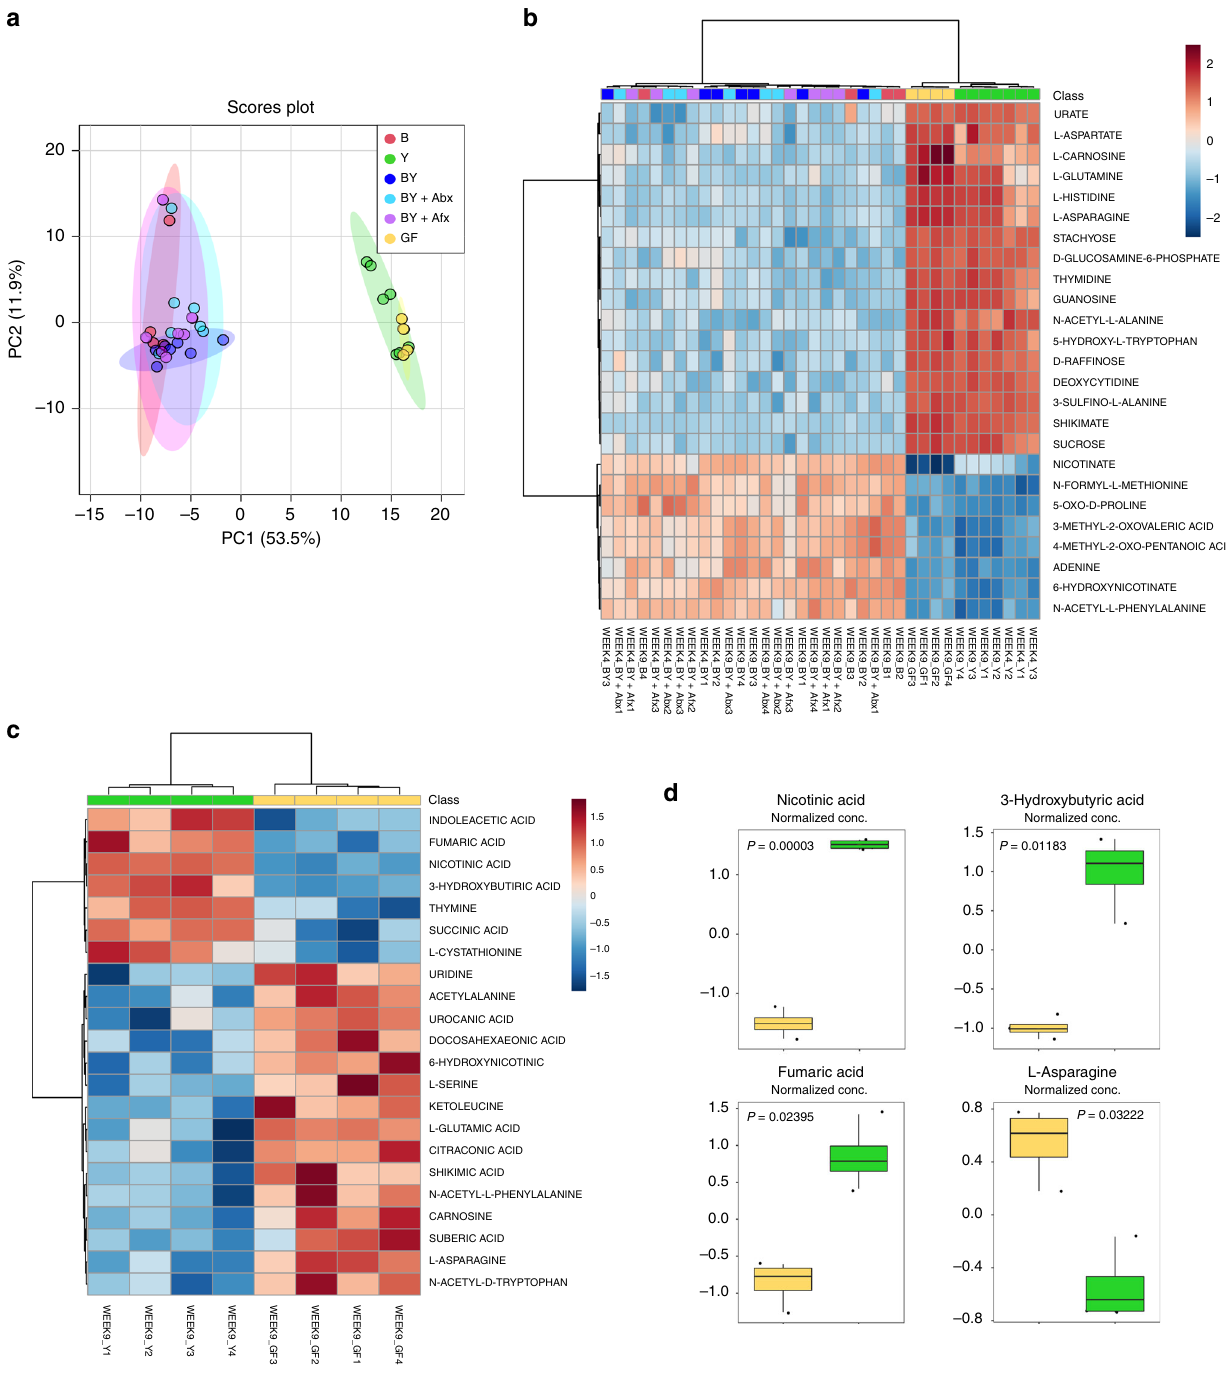
Fig. 4 Bacteria colonization is the main driver of changes in the fecal metabolome. a Principal component analysis score plot of 150 metabolites detected in fecal samples of gnotobiotic mice at 4 and 9 weeks of age. b Heat map of top 25 differentially expressed metabolites detected in 4- and 9-week fecal samples. c Heat map of 22 metabolites differentially expressed between GF and Y groups at 9 weeks. d Strongest metabolic differences detected between GF and Y groups at 9 weeks. a – d Color denotes colonization treatment (GF = yellow, B = red, Y = green, BY = royal blue, BY + Abx = cyan blue, BY + Afx = purple); N week4 = 3 per group; N week9 = 4 per group. a , b Statistically signi fi cant differences between groups determined by one-way ANOVA with Fisher ’ s post hoc FDR correction; P < 0.05 (refer to Supplementary Table 4). c , d Statistically signi fi cant differences de fi ned by two-tailed t -test with FDR correction; P < 0.05 (refer to Supplementary Table 5). d Boxplots indicate median (inside line) and 25th and 75th percentile as the lower and upper hinges, respectively. Source data are provided as a Source data fi (Fig. 5c), and a non-signi fi cant increase in IgE compared with B group (Supplementary Fig. 6c). As well, BY and BY + Abx mice displayed increased levels of IgA and IgG3 (Fig. 5c). Importantly, and IL-12 (Supplementary Fig. 6b). Exclusive fungal colonization these striking systemic immune changes were not a result of resulted in decreased serum IgG3, as well as increased IgG1